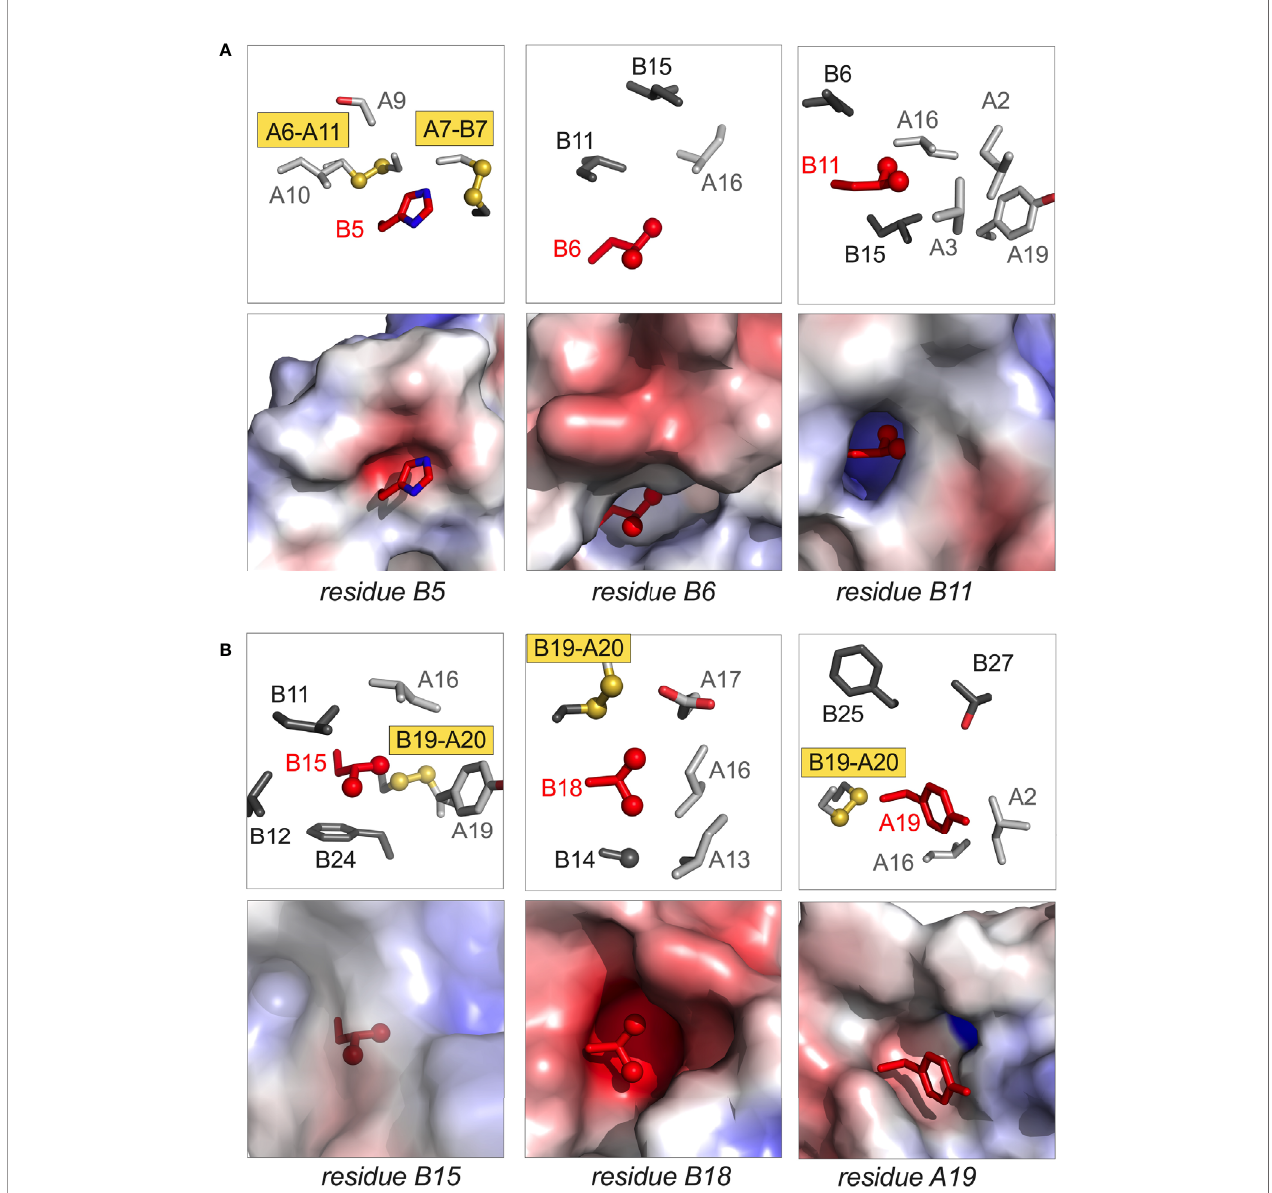
FIGURE 3 | Structural sites of neonatal-onset mutations. (A) Spatial environments of residues B5, B6, and B11; (B) spatial environments of residues B15, B18 and A19. In each panel the highlighted side chain is shown in red; in each pair of images, stick models are shown in upper panels whereas electrostatic surfaces (calculated in absence of indicated side chain) are shown in the lower panels. In stick models, side chains belonging to the A- and B chains are respectively shown in light and dark gray; Cys-related sulfur atoms (gold) and aliphatic methyl groups (red) are represented as spheres (one-third Van der Waals radii). Coordinates were obtained from PDB entry 4INS